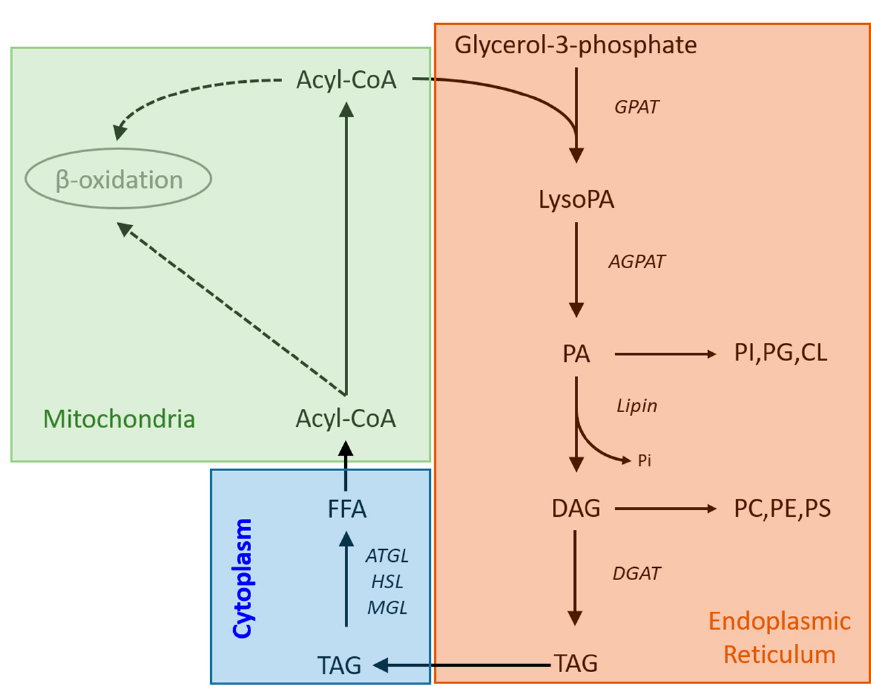
Figure 3. Metabolic pathways showing the routes of triglyceride synthesis and breakdown. Abbre- viations: AGPAT; acylglycerol-phosphate-acyltransferase, ATGL; adipose triglyceride lipase, CL; cardiolipin, DGAT; diglyceride acyltransferase, GPAT; glycerol-phosphate-acyltransferase, HSL; hormone sensitive lipase, LysoPA; lysophosphatidyladipic acid, MGL; monoglyceride lipase, PA, phosphatidic acid, PC; phosphatidylcholine, PE; phosphatidylethanolamine, PG; phosphatidylglyc- erol, PI; phosphatidylinositol, PS; phosphatidylserine.